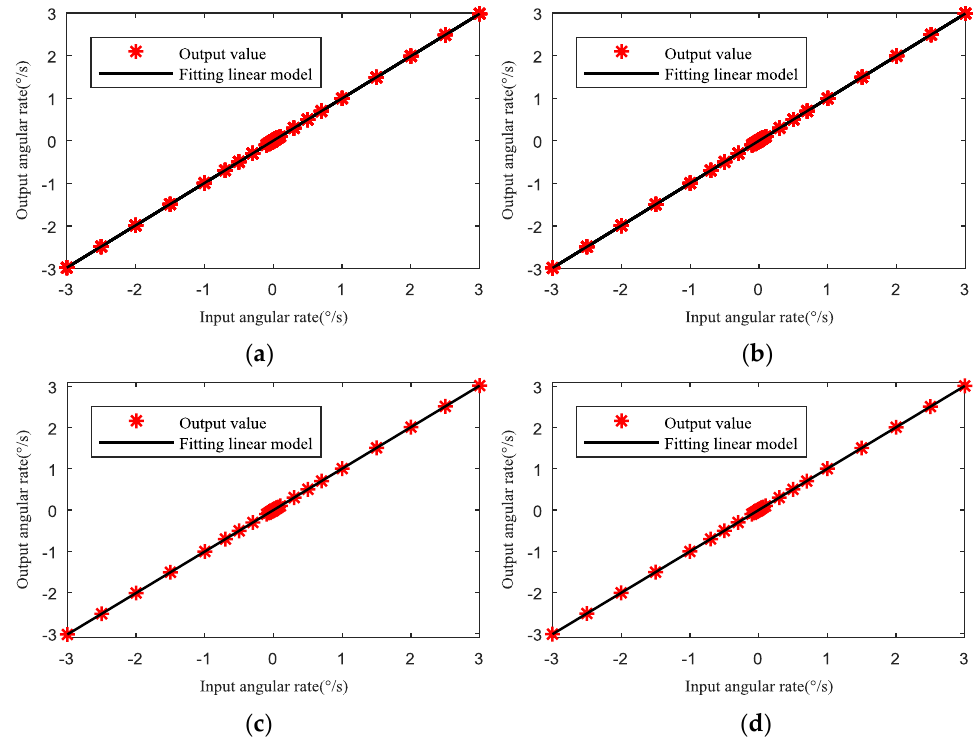
Figure 10. The fitting curves of the HRG output under the same harmonic amplitude (1 μm) and different initial phases (0°, 90°, 180°, and 270°) of uneven capacitance gap are respectively: ( a ) Initial phase 0°; ( b ) Initial phase 90°; ( c ) Initial phase 180°; ( d ) Initial phase 270°.